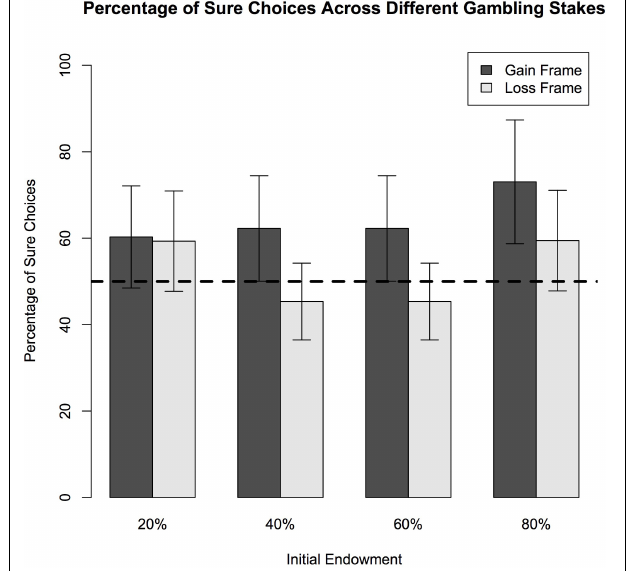
FIGURE 3 | Behavioral results of decisions across varying probabilities of gambling stakes. The plot shows the percentages of trials in which subjects chose the sure option in the gain and loss frames for four different gambling probability percentages. In a 2 × 4 (frame-by-percentage) ANOVA analysis revealed a main effect of frame [ F (2,19 = 17.31, p < 0.001]. Participants demonstrated risk-aversion (i.e., choosing the sure option) more frequently as the initial endowment increased. Increased age predicted higher sure choices only in the 80% probability percentage category [ F (4,193) = 2.77, p = 0.026] but did not predict choices in the other probability percentages. Also, a main effect of endowment amounts [ F (4,193) = 41.69, p < 0.001] demonstrated that participants had higher framing effects with increasing probability percentages. The effect of initial endowment on sure choices was significantly greater in the loss frame than in the gain frame (the interaction of frame-by-initial amount) [ F (3,193) = 4.23, p = 0.007].